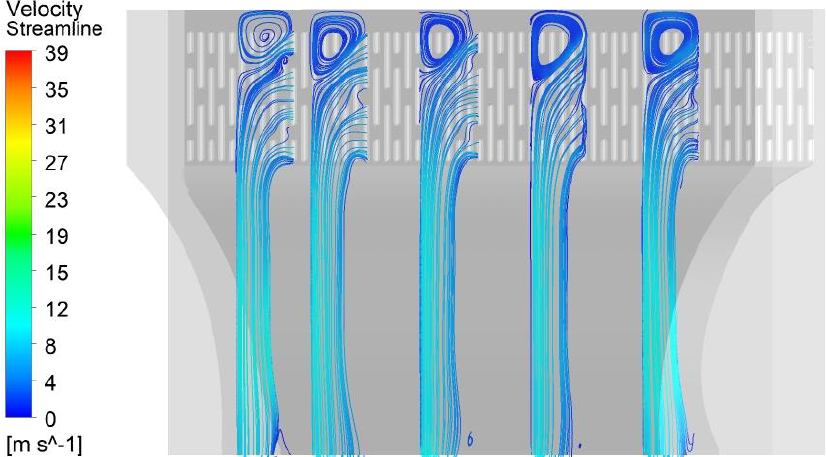
Figure 19. Flow diagram of different X-directional cross-sections in the optimized head duct of the integrated stove.